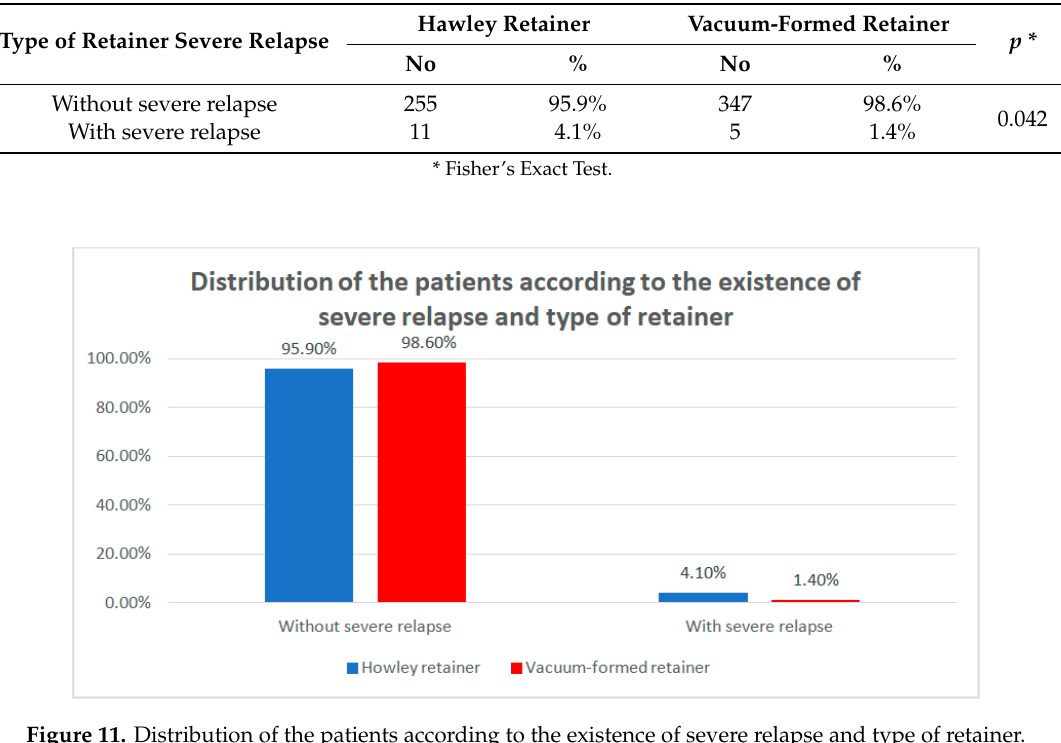
Figure 11. Distribution of the patients according to the existence of severe relapse and type of retainer.